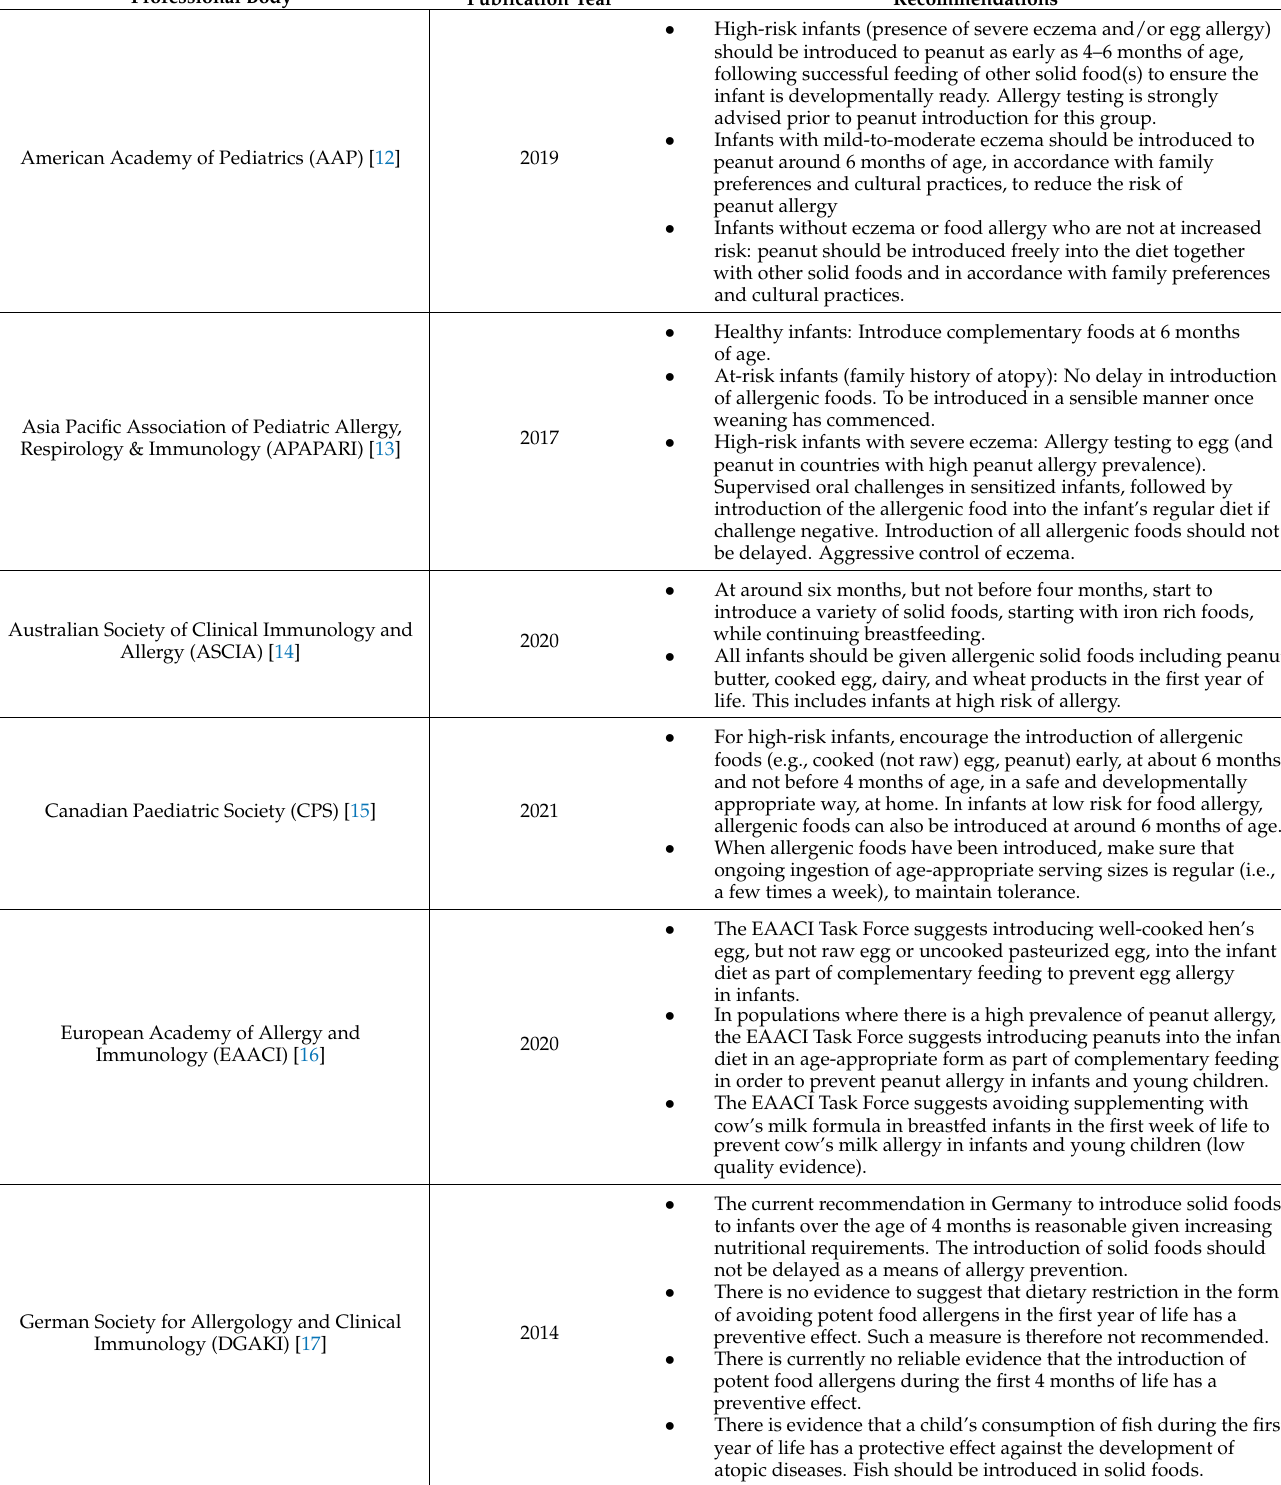
Table 1. A summary of international consensus guidelines on early introduction of allergenic